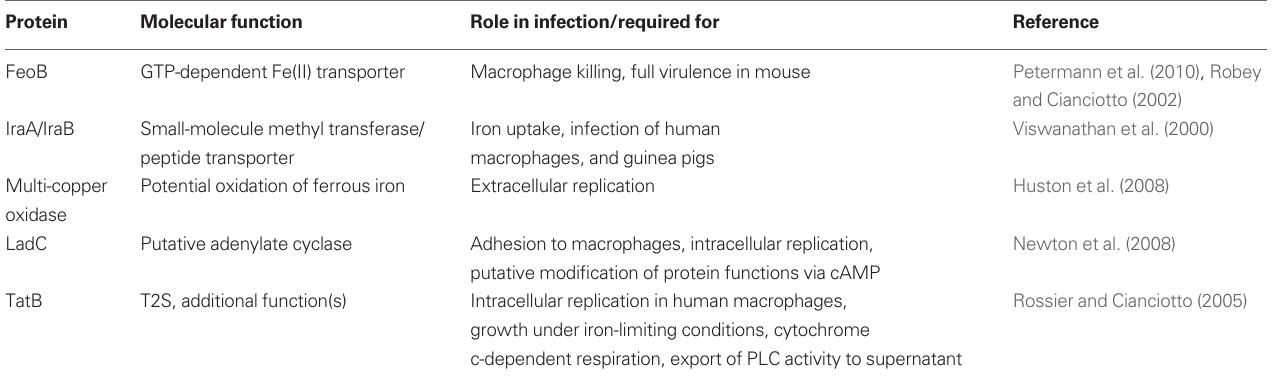
Table 1 | inner membrane proteins of L. pneumophila associated with virulence and survival . Protein Molecular